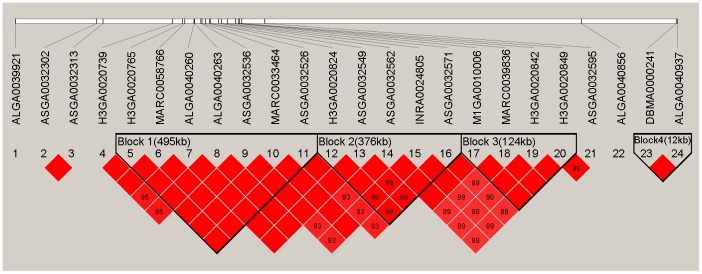
Haplotype block at linkage disequilibrium (LD) on a 4.76 Mb region on SSC7.Solid lines mark the three blocks identified. The block1 of 495(LD, r2 = 1).